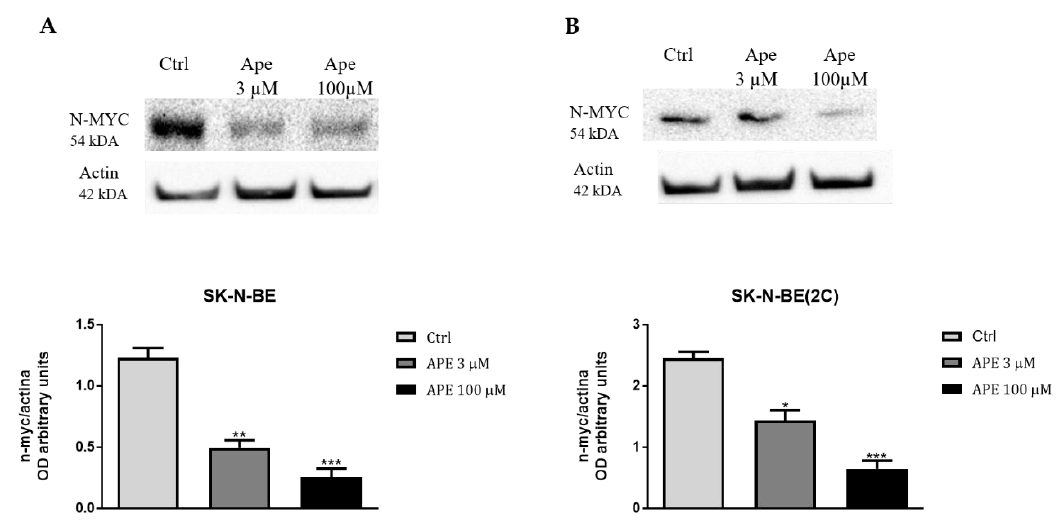
Figure 9. Western blot analysis of N-MYC protein expression after 3 or 100 µM of APE treatment in SK-N-BE ( A ) and SK-N-BE(2C) cells ( B ). β-actin was used to normalize the amount of total proteins loaded in each lane. The graph below reports the densitometric analysis of the band of N-MYC normalized with β-actin, obtained from three independent experiments (* p < 0.05; ** p < 0.01; *** p < 0.001; t -test APE vs. ctrl).